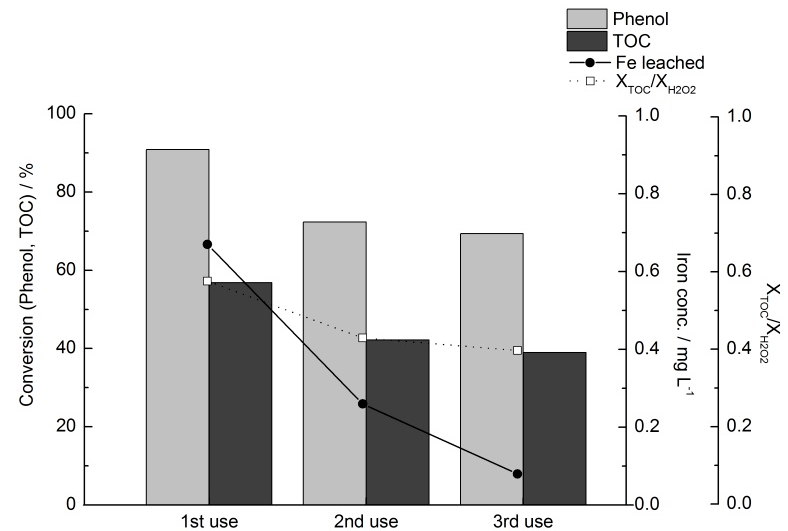
Figure 7. Conversions of phenol and TOC (respectively dark and light bars / left axis) and concentration of iron leached into solution and X TOC / X H 2 O 2 (respectively squares and circles/right axis), obtained after 24 h in a series of three CWPO runs performed with consecutive reuse of ROXN 673 under the conditions given in Figure 2.